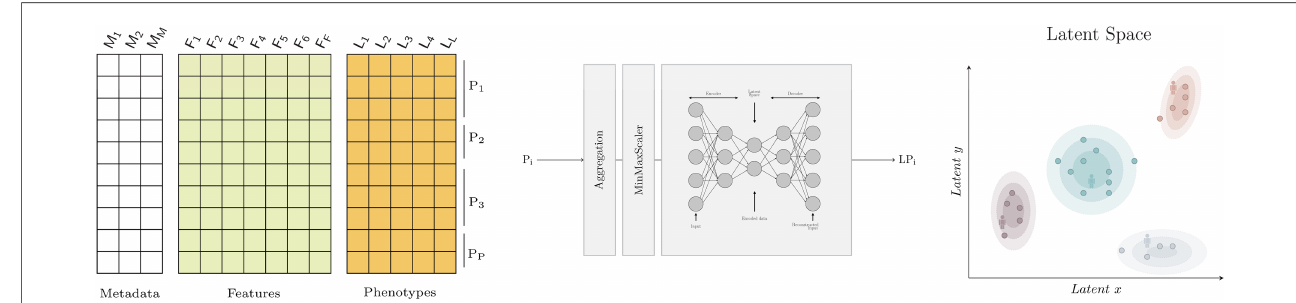
FIGURE 1 Graphical abstract. On the left, the dataset with metadata, features and phenotypes where each row represents a daily patient pro fi le. In the middle, the model that transforms a patient stay with one or more daily pro fi les (P i ) into a two dimensional embedding (LP i ) for visualisation. The aggregation step is used to describe the worst patient status using the aggregation functions shown in Table 1 . The embeddings are obtained using autoencoders. On the right, the latent space where similar patients are grouped together. Each point represents a patient and the shaded areas represent the density distribution; that is, the concentration of patients for which the phenotype of interest occurs. Note that the latent space can be used to visualise any feature or phenotype of interest.